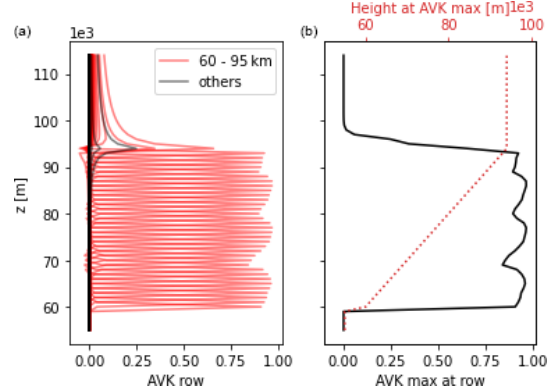
Figure 3. Data density from the Odin launch until 2018. The num- ber of orbits that contain at least one limb radiance profile (grey) and that contain at least one OH nightglow profile that is inverted to a volume emission rate (VER) profile (red).